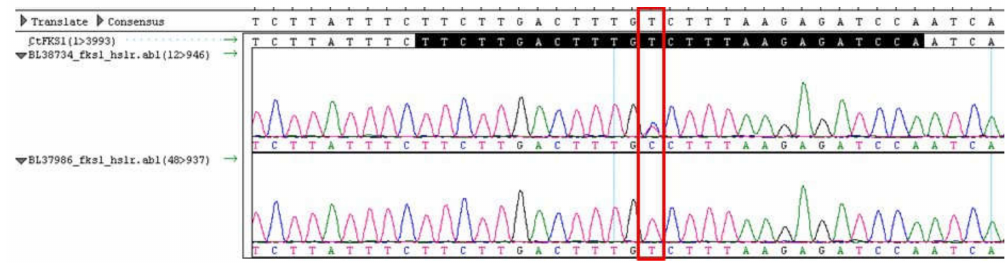
Figure 1. DNA sequencing chromatograms for Candida tropicalis BL37986 and BL38734 isolates identified in blood of Index case #1. Hot spot 1 region sequence is shown in black in the reference strain ATCC750 used as control. The red box indicates the T-to-C